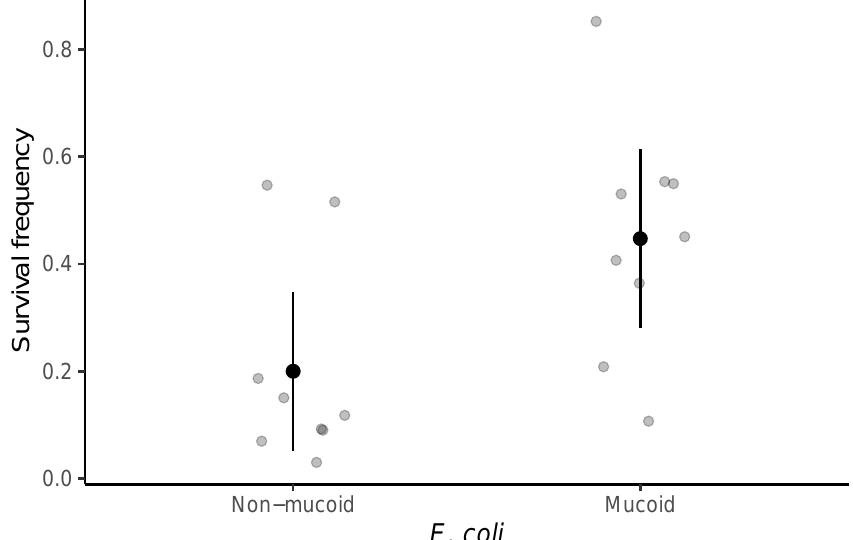
Figure 3. Mucoidy is associated with higher survival of encounters with M. xanthus . Frequencies of prey surviving encounters with M. xanthus are shown. Grey dots are mean survival frequency for clones from each of nine coevolving populations from which the clones were isolated at the end of cycle 18. Three independent estimates were generated for each population (Figure 5b). Black dots are means across the nine populations for each prey type and error bars show 95% confidence intervals ( t